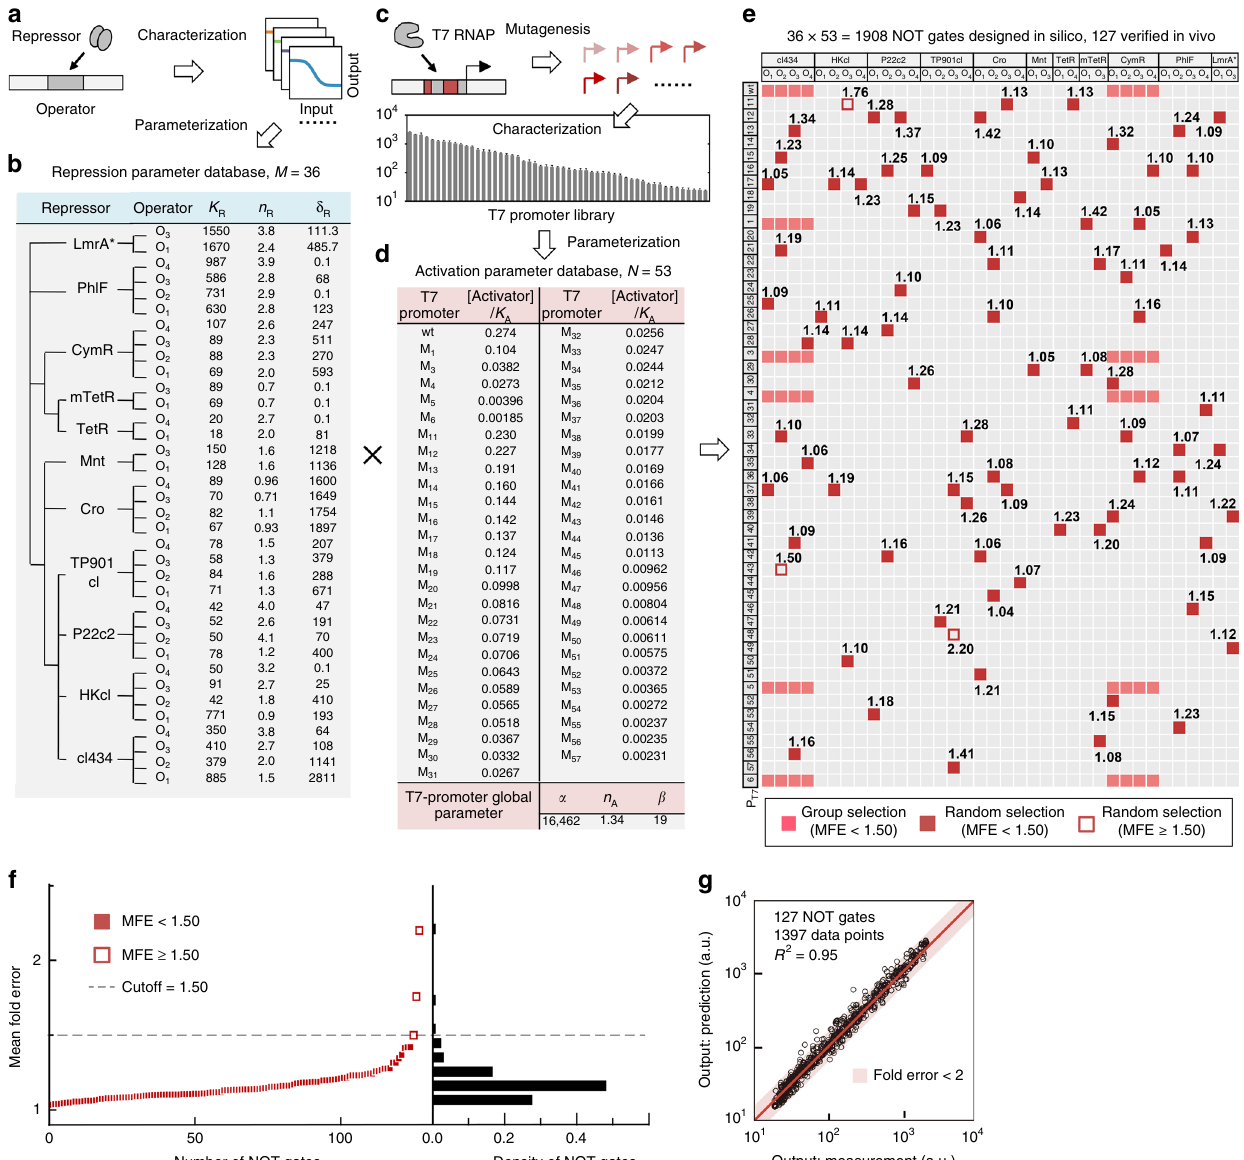
Fig. 5 High-precision manufacturing of combinatorial promoters encoding NOT-gate functions. a Flow diagram depicting creation of the repression-dependent parameter database. b Repression database consisting of 36 sets of repression-dependent parameters with diverse dynamic features. The parameter values are given for each repressor – operator pair. c Flow diagram illustrating construction of the repression-dependent parameter database. d Activation database consisting of 53 sets of activation-dependent parameters. The value for [Activator]/ K A is provided for each T7-RNAP promoter core; the values of α , n A and β are constant throughout the library. e Combination of activation- and repression-dependent parameter databases to design combinatorial promoters that function as NOT gates. The combinations selected for experimental evaluation are highlighted in pink and red . Pink rectangles denote combinations selected as groups (data for cI 434 operators are shown in Fig. 4e; data for cymR operators are shown in Supplementary Fig. 5). Red rectangles or boxes denote randomly selected combinations. The response functions were measured, and the corresponding mean relative(-fold) error (MFE) values were calculated for each selected combinational promoter. f Illustration of the achieved precision of promoter design for all 127 combinatorial promoters. A total of 124 of the promoter designs exhibited mean relative(-fold) errors < 1.5, with most having error values between 1.1 and 1.2. g Comparison of experimental measurements with model predictions for all 1397 data points for 127 combinatorial promoters encoding NOT-gate functions. R 2 was calculated by linear regression. At least three biological replicates were used to measure each promoter ’ s response function. The data shown in b and d were obtained from model fi tting of experimental measurements. The MEF in e and f was calculated as described in the legend for Fig.